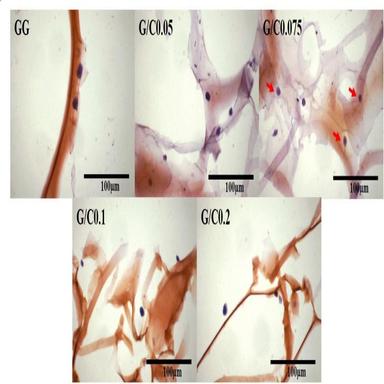
Histological images of (A) H&E and (B) Safranin-O.